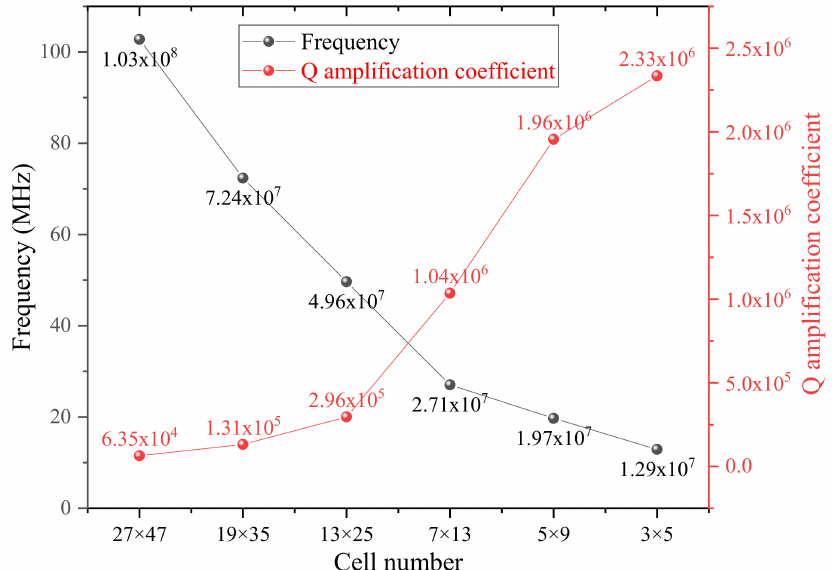
Figure 5. The quality factor amplification coefficients (red) of all six structures along with the resonant frequencies (black). The Q amplification coefficient of the structure making up from the 3 × 5 cells, which is the least number to compose a phononic crystal with a central defect area, is the